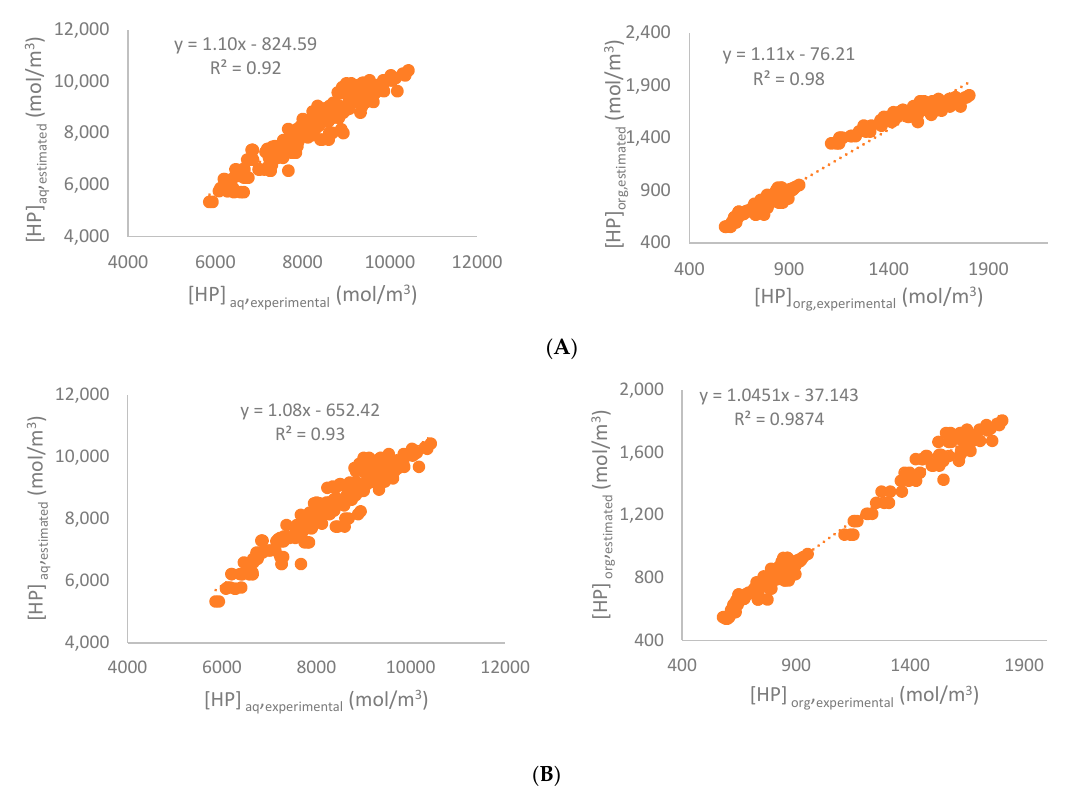
~0 Table 7. Normalized covariance matrix for the estimated kinetic constants for Models c and d for the heterogeneous liquid phase system. Model c (Decomposition)